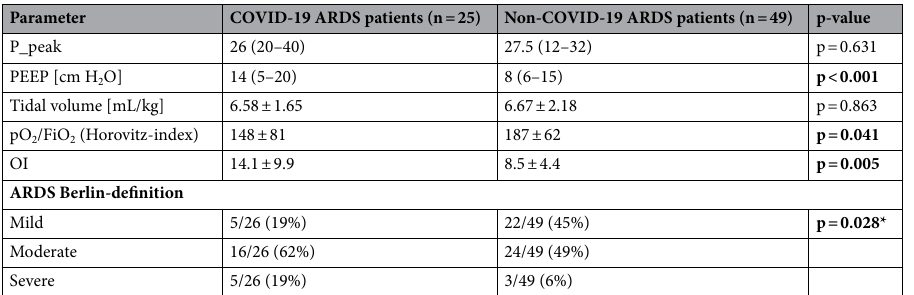
Table 2. Respiratory baseline parameters. * mild vs. moderate/severe, P_peak maximal inspiratory pressure, PEEP positive end-expiratory pressure, pO 2 partial pressure of oxygen, OI oxygenation index, ARDS acute respiratory distress syndrome, tidal volume is reported in ml/kg predicted body weight, significant p-values are displayed in bold letters.